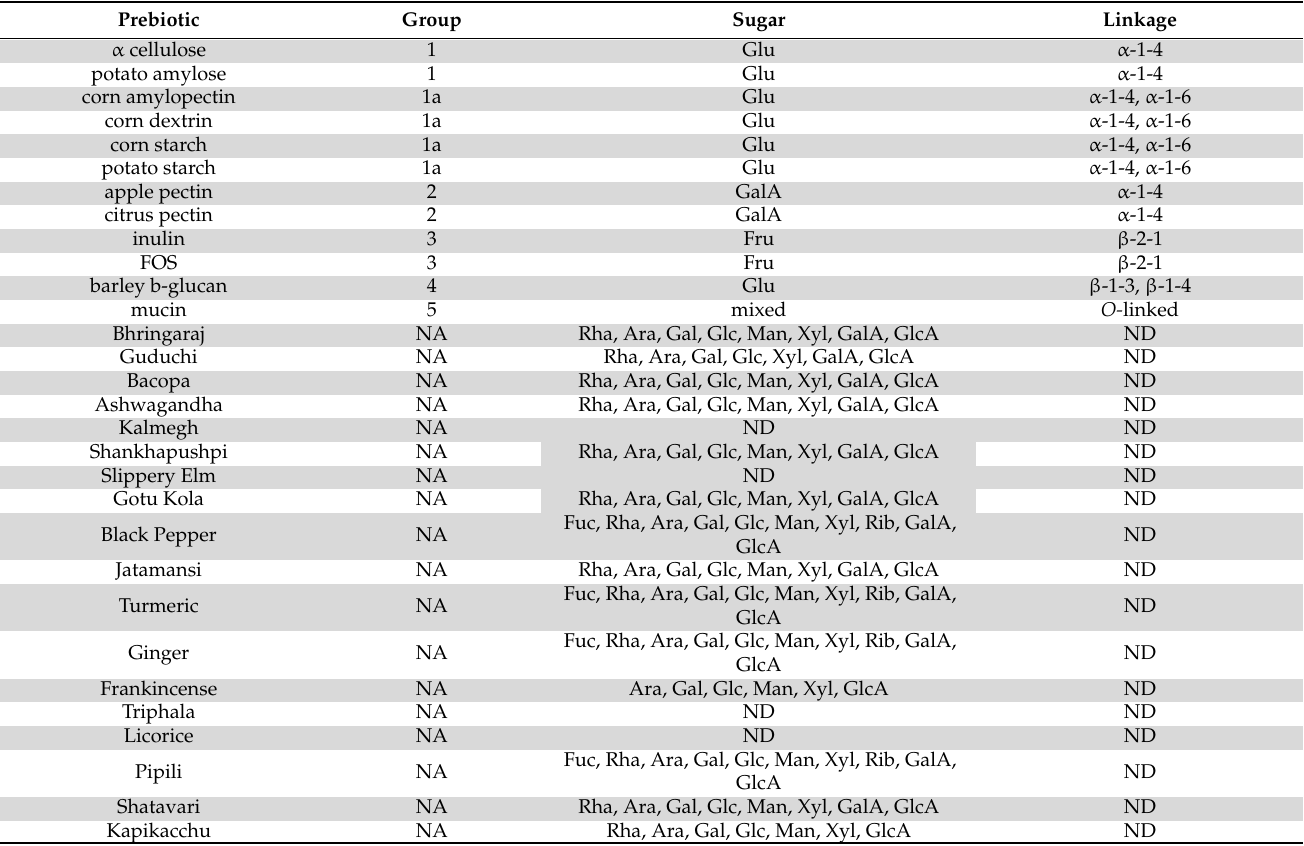
Table 1. Prebiotic composition and